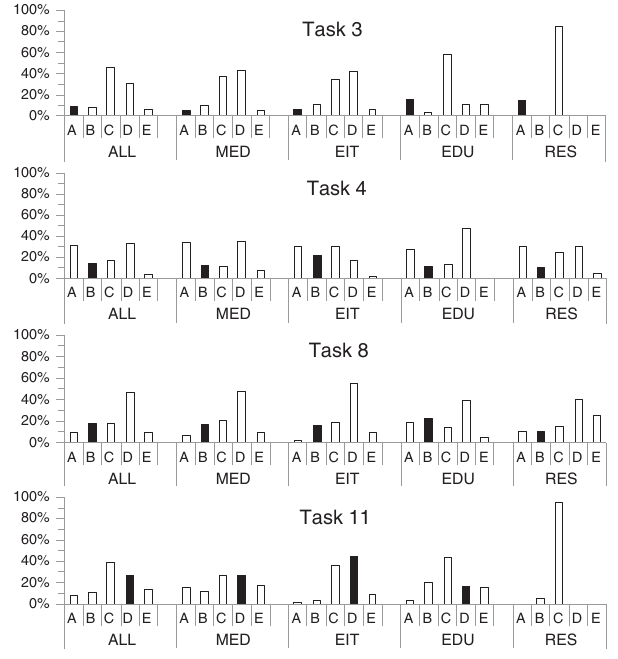
FIG. 4. The students ’ responses to the tasks grouped by the intermolecular potential energy concept concerned. For a detailed description see Fig.